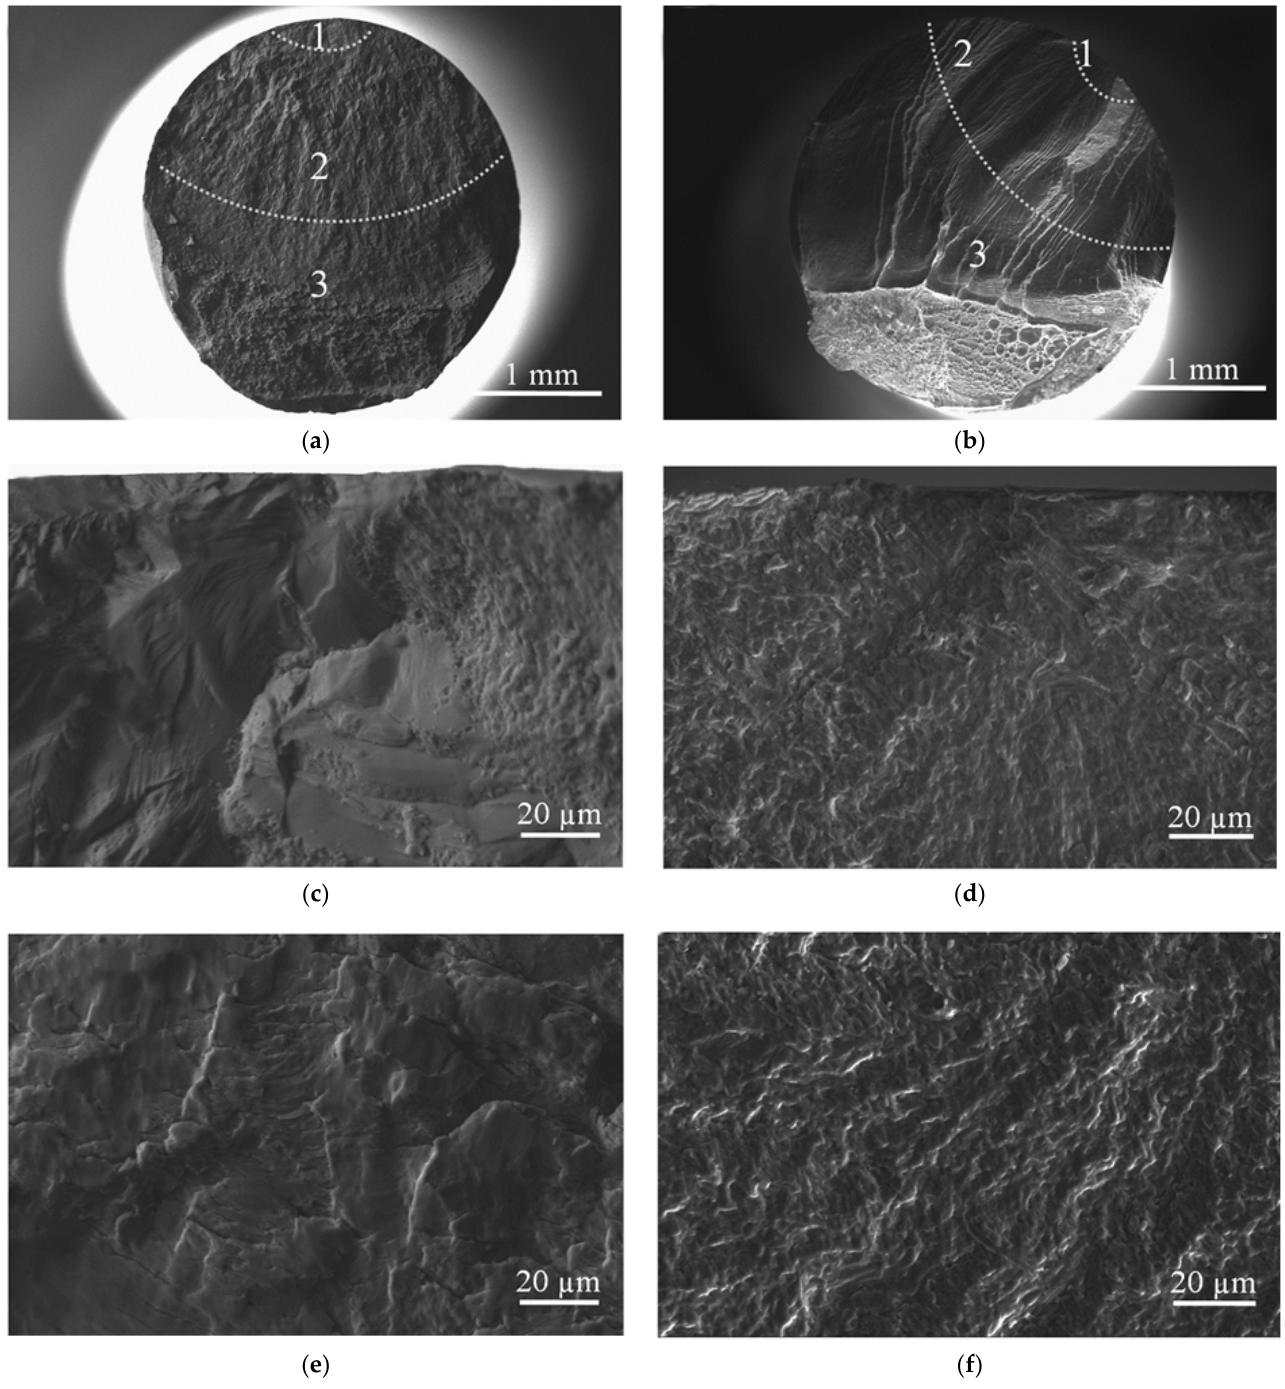
Figure 12. SEM micrographs of fracture surface of ( a , c , e ) CG and ( b , d , f ) UFG Ti-45Nb alloy samples: ( b , d ) crack initiation zone; ( e , f ) crack propagation zone.